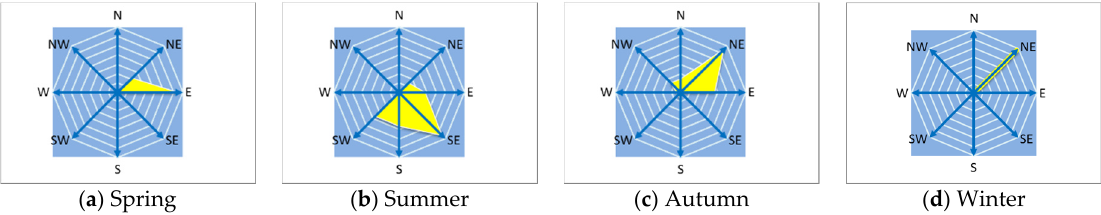
Figure 6. Wind rose for each season in Shenzhen from March 2013 to February 2014. ( a ) Spring; ( b ) Summer; ( c ) Autumn; ( d ) Winter.